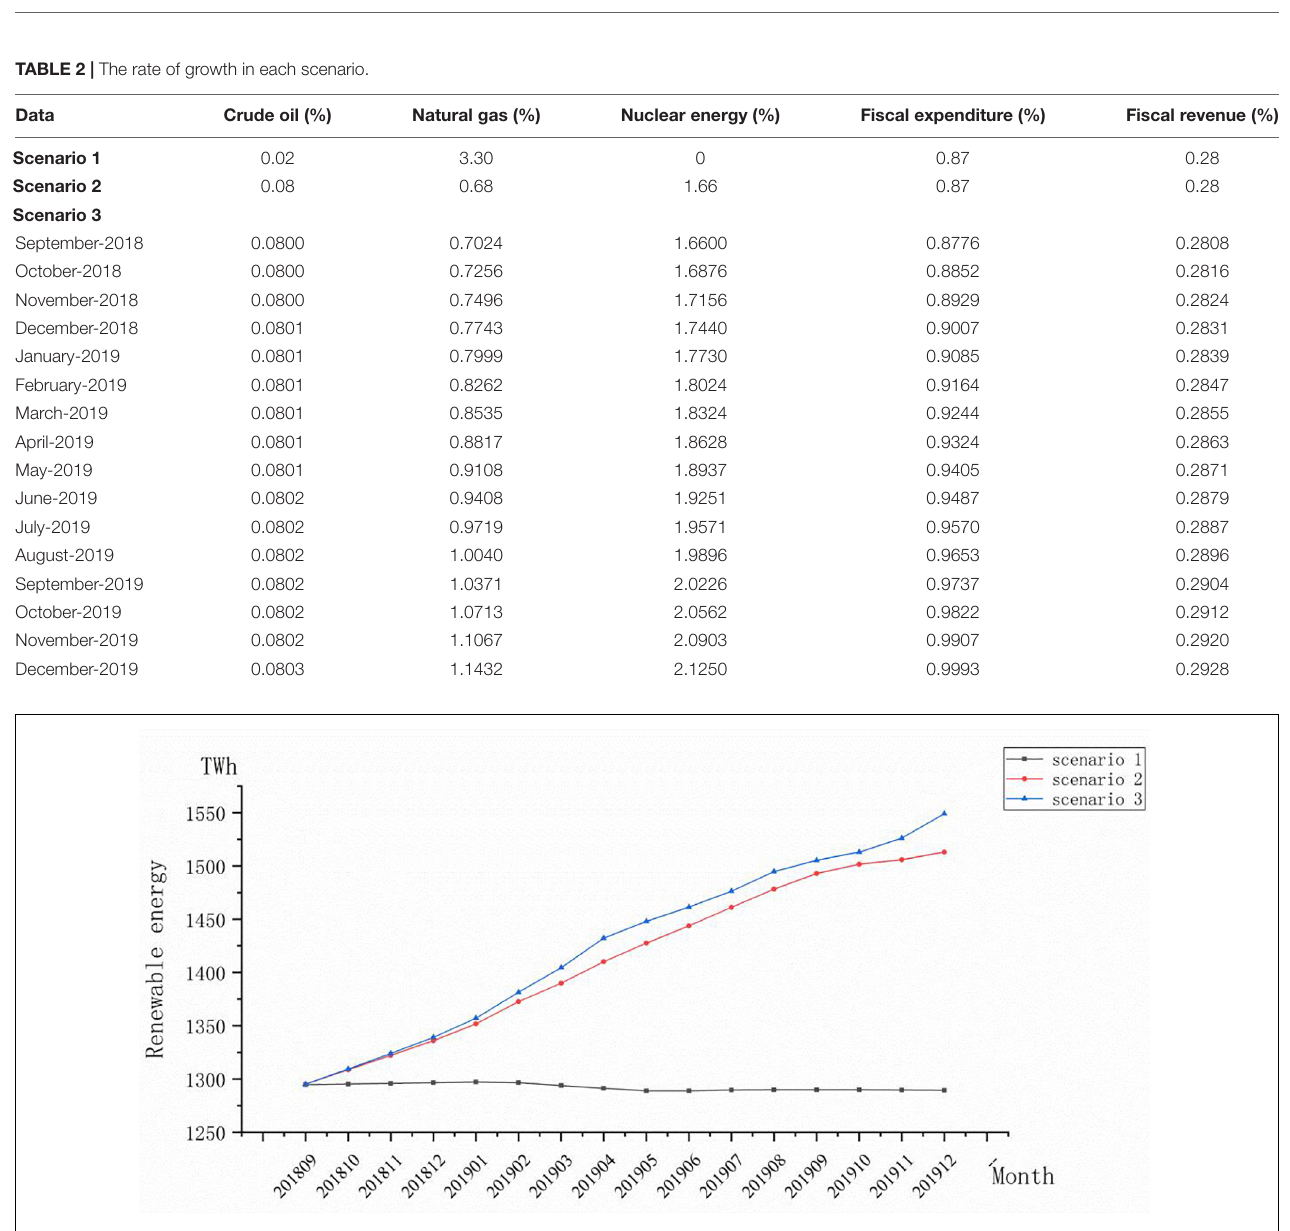
FIGURE 4 | Renewable energy sources providing power forecasts in various